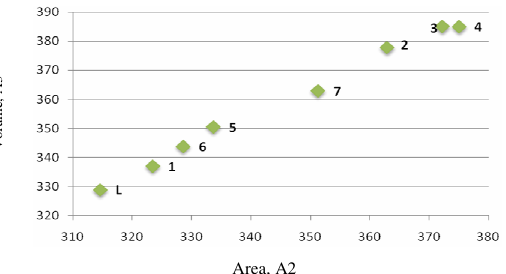
Figure 3. Correlation between area and volume